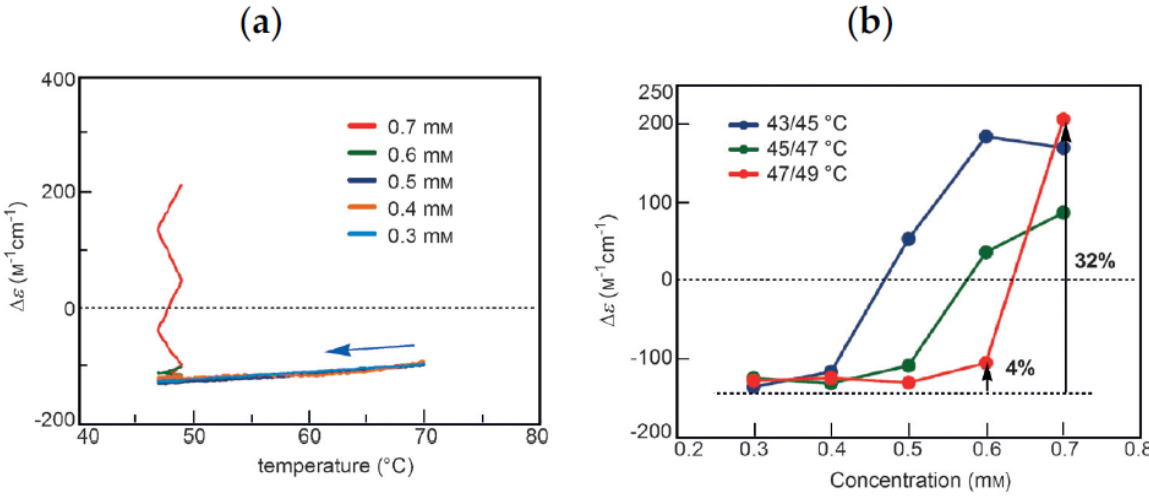
Figure 20. ( a ) Concentration threshold of ( P )– 1 in 1,3-difluorobenzene by repeated temperature changes between 47 and 49 ◦ C. ( b ) Experiments at different concentrations shown by ∆ ε at the second heating. Reproduced from ref. [67] with permission from